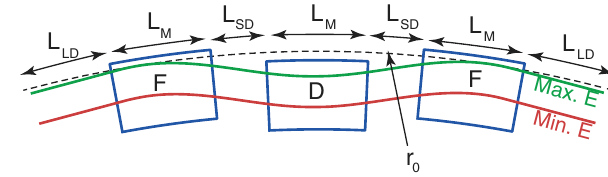
FIG. 1. Geometry of the FDF triplet cell used in NORMA showing the sector-type magnets in blue, the minimum and maximum energy orbits (30 and 350 MeV) in red and green, respectively, and the reference radius r 0 as a dashed black line. For optimizing the geometry, the free parameters were selected as ¼ 2 L þ 3 L þ 2 L the cell length L LD M SD , the triplet length cell L ¼ 3 L þ 2 L α ¼ L =L . M SD , and the packing factor trip trip cell